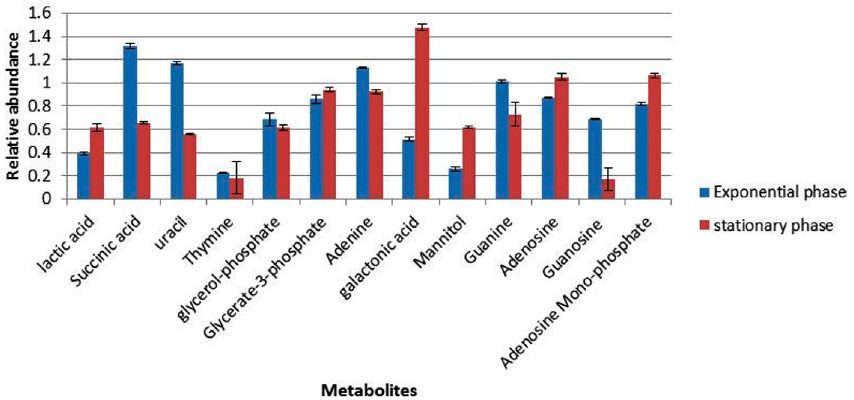
Fig. 1. The relative abundances of cytoplasmic metabolites extracted from clinical isolate of S. aureus harvested at mid-exponential and stationary phases grown under ideal